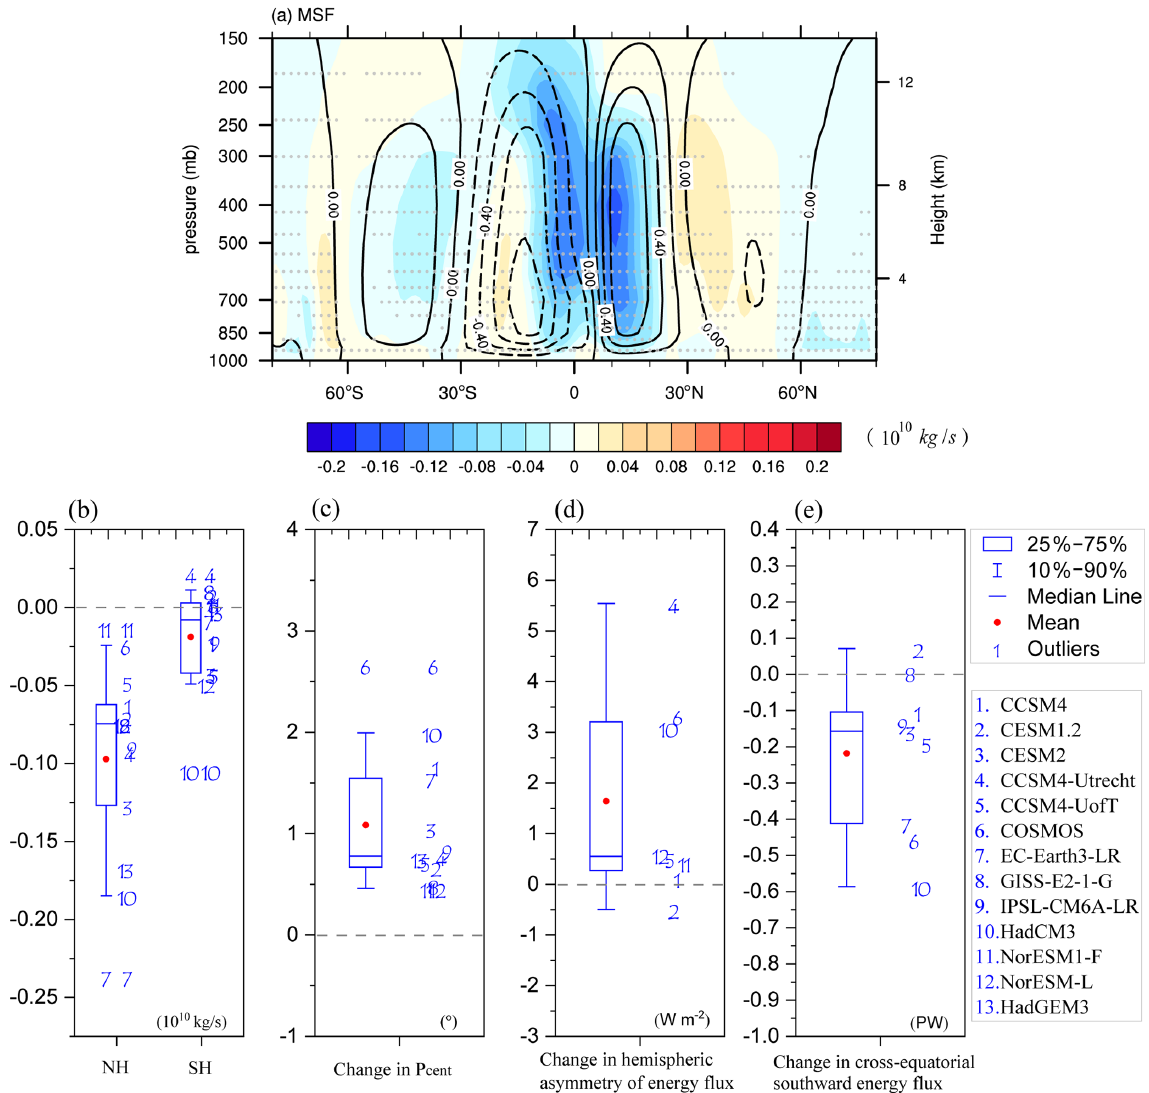
Figure 8. (a) Changes in the annual mean mass stream function (MSF; shading; in 10 10 kgs − 1 ) of meridional circulation for mid-Pliocene with respect to the PI simulation, overlaid by the climate mean MSF for the PI simulation (contours). The meridional wind V M is decomposed from the 3P-DGAC method. Solid curves indicate positive values, and dashed curves indicate negative values. Stippling indicates regions where at least 10 of 13 simulations in the model group agree on the sign of the ensemble mean. (b) Changes in the annual mean intensities (in 10 10 kgs − 1 ) of meridional circulation in the NH and SH. (c) The latitudes of the center of annual mean precipitation (Pcent) between 20 ◦ S and 20 ◦ N (in ◦ ). (d) Hemispheric asymmetry (NH minus SH) of the energy flux into the atmosphere (in Wm − 2 ). (e) Changes in the integrated atmospheric meridional heat transport across the Equator (in